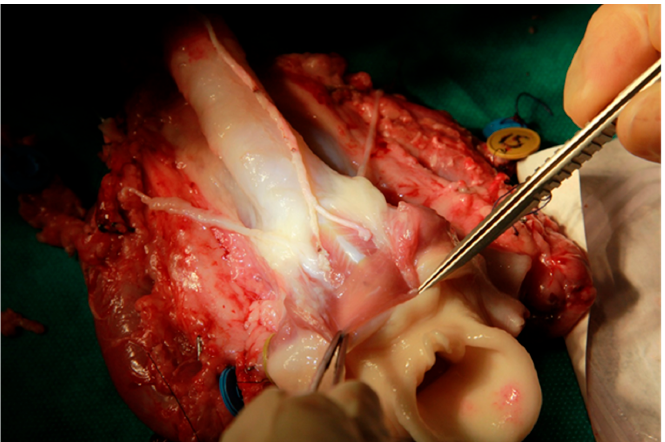
Figure 2. The neurological step with bilateral neurotisation of the posterior cricoarytenoid muscles using a Y-shaped graft of large auricular nerve taken from the donor.